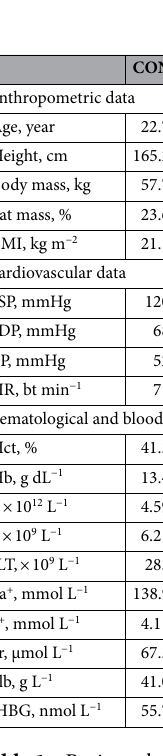
Table 1. Basic anthropometric, cardiovascular, hematological and serum biochemical parameters of the controls (CON, n = 15) vs female athletes (ATH, n = 15). Data are given as mean ± SD. BMI body mass index, cSP central systolic blood pressure, cDP central diastolic blood pressure, PP pulse pressure, HR heart rate, Hct hematocrit value, Hb hemoglobin concentration, E erythrocyte count, L leukocyte count, PLT platelet count, Na + sodium concentration, K + potassium concentration, Cr creatinine concentration, Alb albumin concentration, SHBG sex hormone-binding globulin